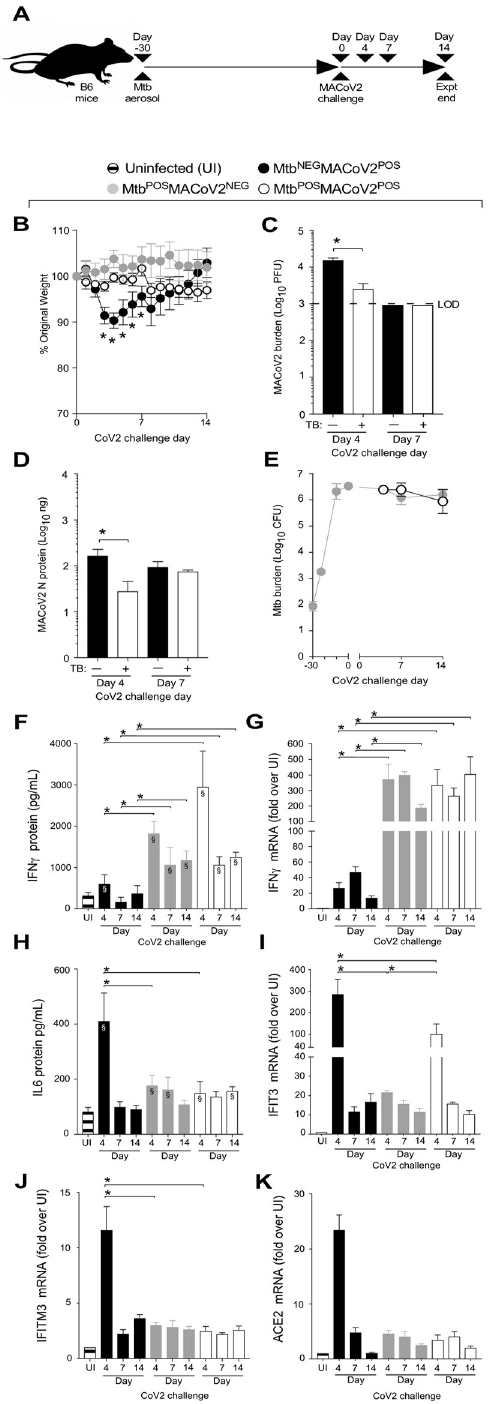
Fig 4. Mtb-infected B6 mice are resistant to secondary infection with MACoV2. ( A ) Experimental overview of our B6:MACoV2 model studies, wherein mice were infected via aerosol with Mtb (Day -30) and challenged 30 days later (Day 0) with MACoV2. On post-challenge Days 4, 7 and14 we collected lung tissue for microbiological and immunological assessments. Experimental groups included B6 mice which were not infected with Mtb prior to MACoV2 challenge (Mtb NEG MACoV2 POS ), B6 mice which were infected with Mtb but challenged with sterile saline (Mtb POS MACoV2 NEG ), and B6 mice which were infected with Mtb prior to CoV2 challenge (Mtb POS MACoV2 POS ). ( B ) The percent weight change experienced by each group of B6 mice following MACoV2 challenge, as normalized to